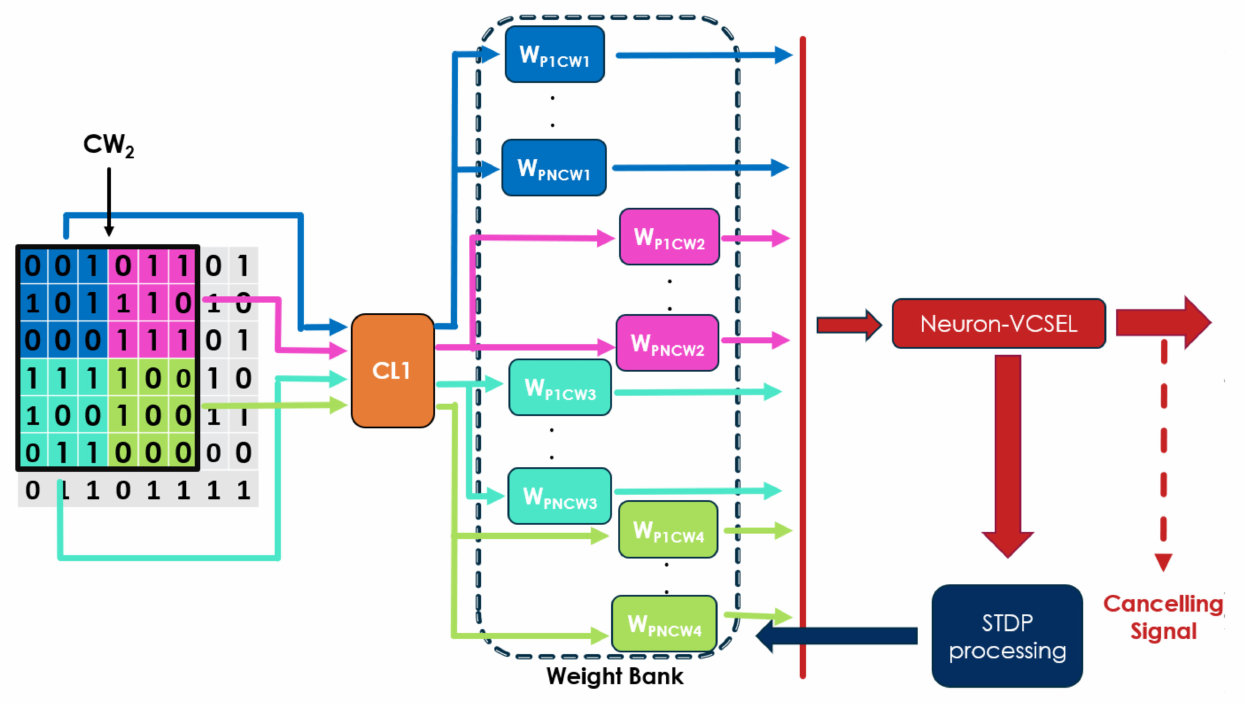
Figure 7. CL2’s neurons layout. W PXCWZ represents weight for the input of the CL1’s neuron, which detects Pattern X in the area of CW Y